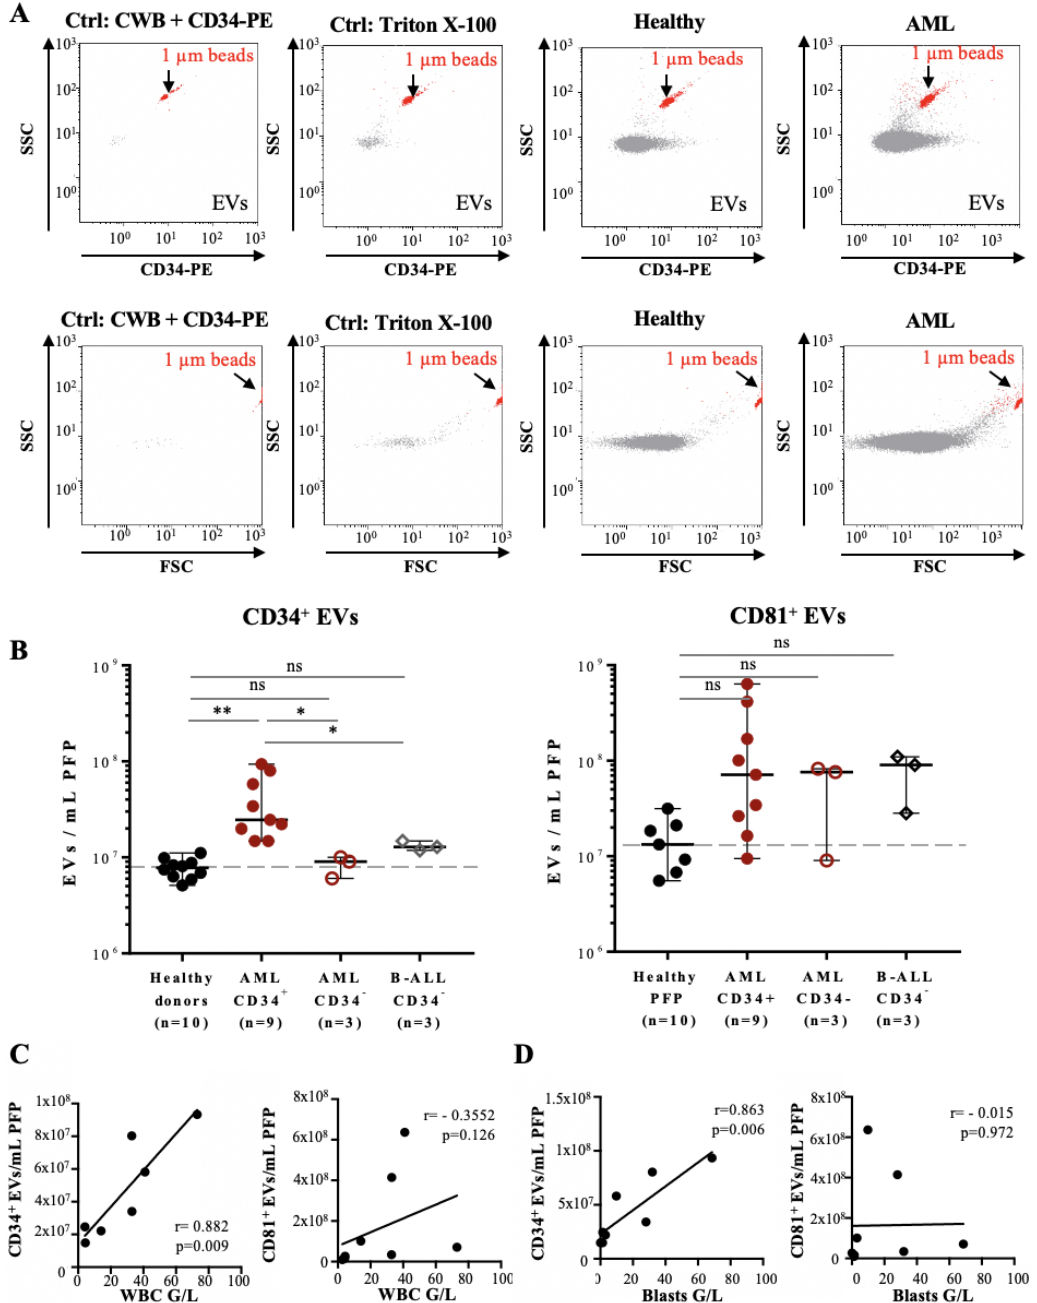
Figure 2. Flow cytometry analysis of PFP samples from leukemia patients based on the fluorescence triggering method: ( A ) Representative FL-2 vs. SSC (upper panels) and FSC vs. SSC (lower panels) dot plots of PFP sample analysis by fluo- rescence triggering: reagents-only control (CWB containing 2% BSA and CD34-PE), negative control (PFP treated with Triton X-100, second panel), HBD (third panel), and AML patient (forth panel). PFP samples were incubated with CD34 - PE antibody and FL-2 fluorescence used as a trigger, so that all detected events correspond to CD34 + EVs (upper panels). Here, 1 µm calibration beads (red) are used as an internal size and volume reference and are indicated in each dot plot. ( B ) Quantification of CD34 + (left panel) or CD81+ EVs (right panel) in PFP from HBDs (n = 10), CD34 + AML (n = 9), CD34- AML (n = 3), and CD34-B-ALL patients (n = 3). Error bars represent ± SEM (n = 3 – 10). One-way ANOVA with post hoc Bonferroni was performed for multiple group comparison. * p < 0.05; ** p < 0.01, and ns — non-significant. ( C ) Scatter plots with linear regression lines showing the correlation between the concentration of CD34 + EVs (left panel) and CD81 + EVs (right panel) per mL of PFP and the total WBC count (G/L) of seven AML patients at the time of diagnosis. r = 0.882, p = 0.009 (left panel), and r = − 0.355, p = 0.126 (right panel). ( D ) Scatter plots with linear regression lines showing the correlation between the concentration of CD34 + EVs (left panel) and CD81 + EVs (right panel) per mL of PFP and the leukemic blast